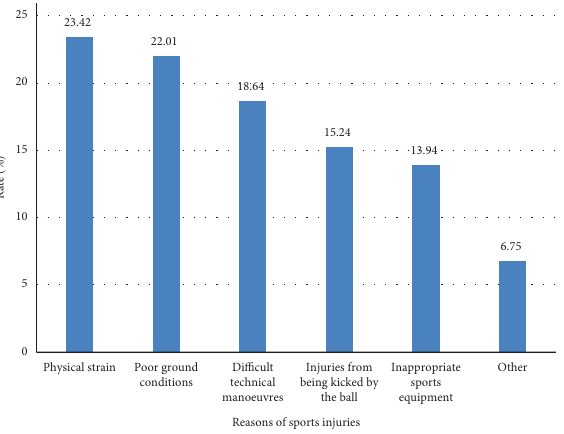
Figure 7: Causes of sports injuries in students.